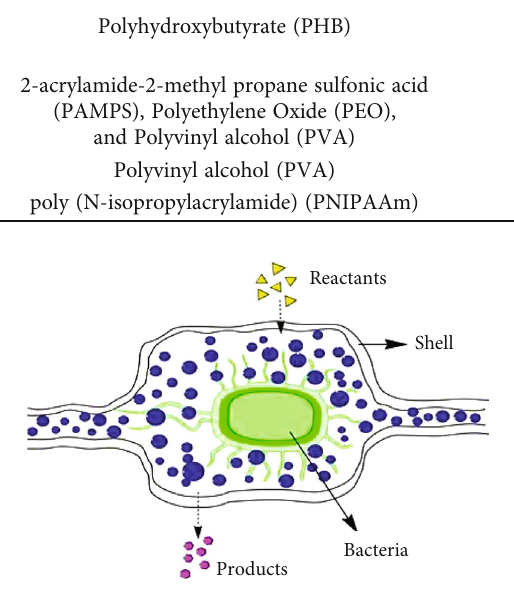
Figure 4: A bacterial cell inside the nano fi ber.